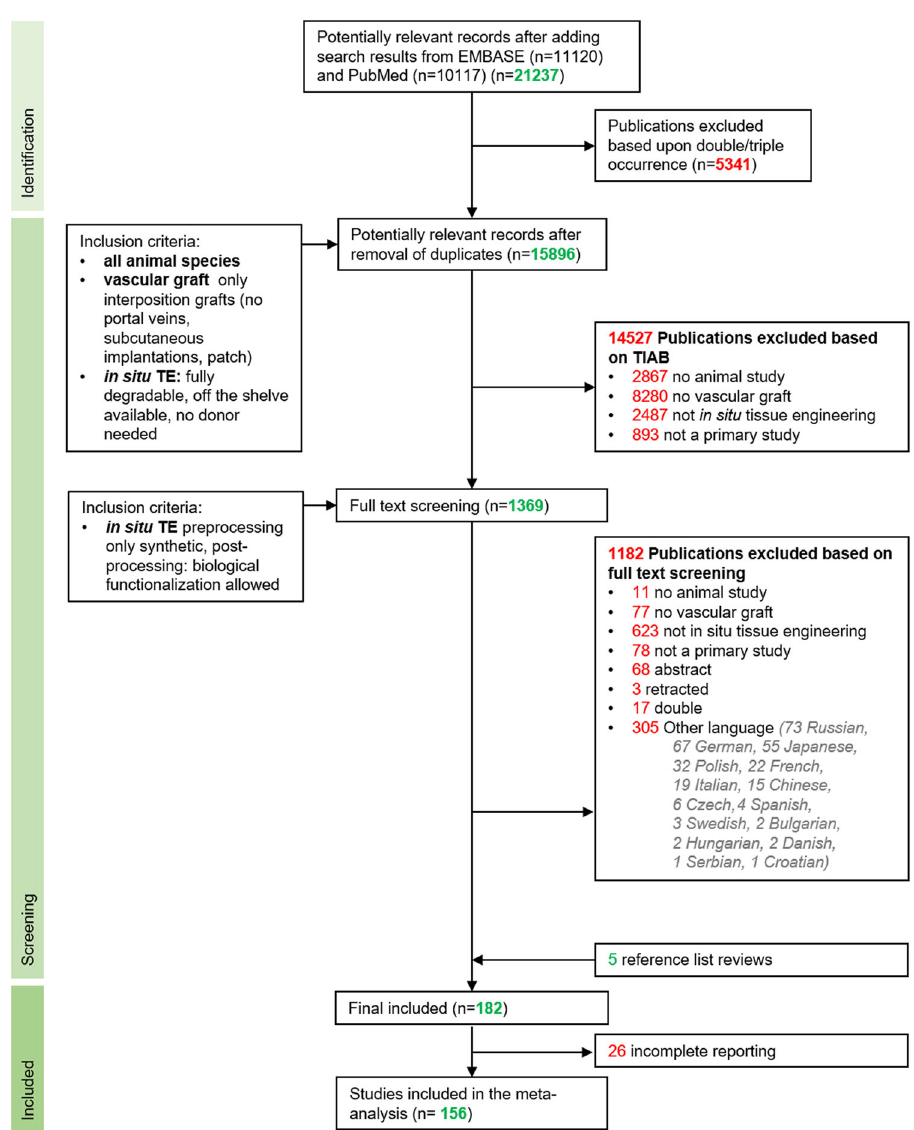
Fig. 1 PRISM fl ow chart of study selection process. The systematic search in Pubmed and EMBASE yielded 15,896 unique publications. After title and abstract screening, articles were screened full text of which 1,182 articles were excluded based on the exclusion criteria. Data from 182 articles (see Supplementary Reference List) was extracted and because of incomplete reporting (e.g., animal number not reported) in 26 articles, 156 articles were included in meta-analysis. Abbreviations: TE tissue